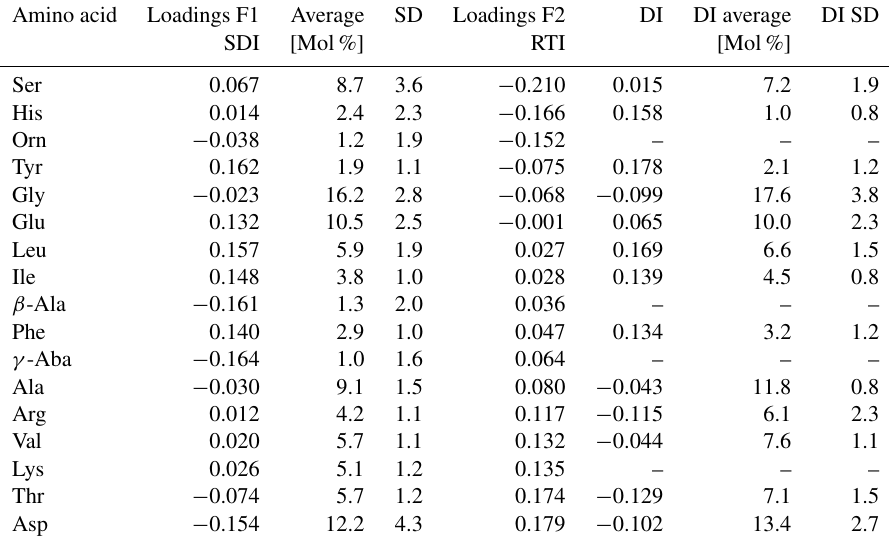
Table 2. Factor loadings of F1 and F2 for calculating the SDI and RTI, respectively, average [Mol%] and standard deviations (SD) of AAs of samples used for the PCA shown in Fig.6 in comparison with the factor loadings (named factor coefficients) of the DI published by Dauwe et al. (1999), and their averages [Mol%] and standard deviations used for the DI based on 28 sediment